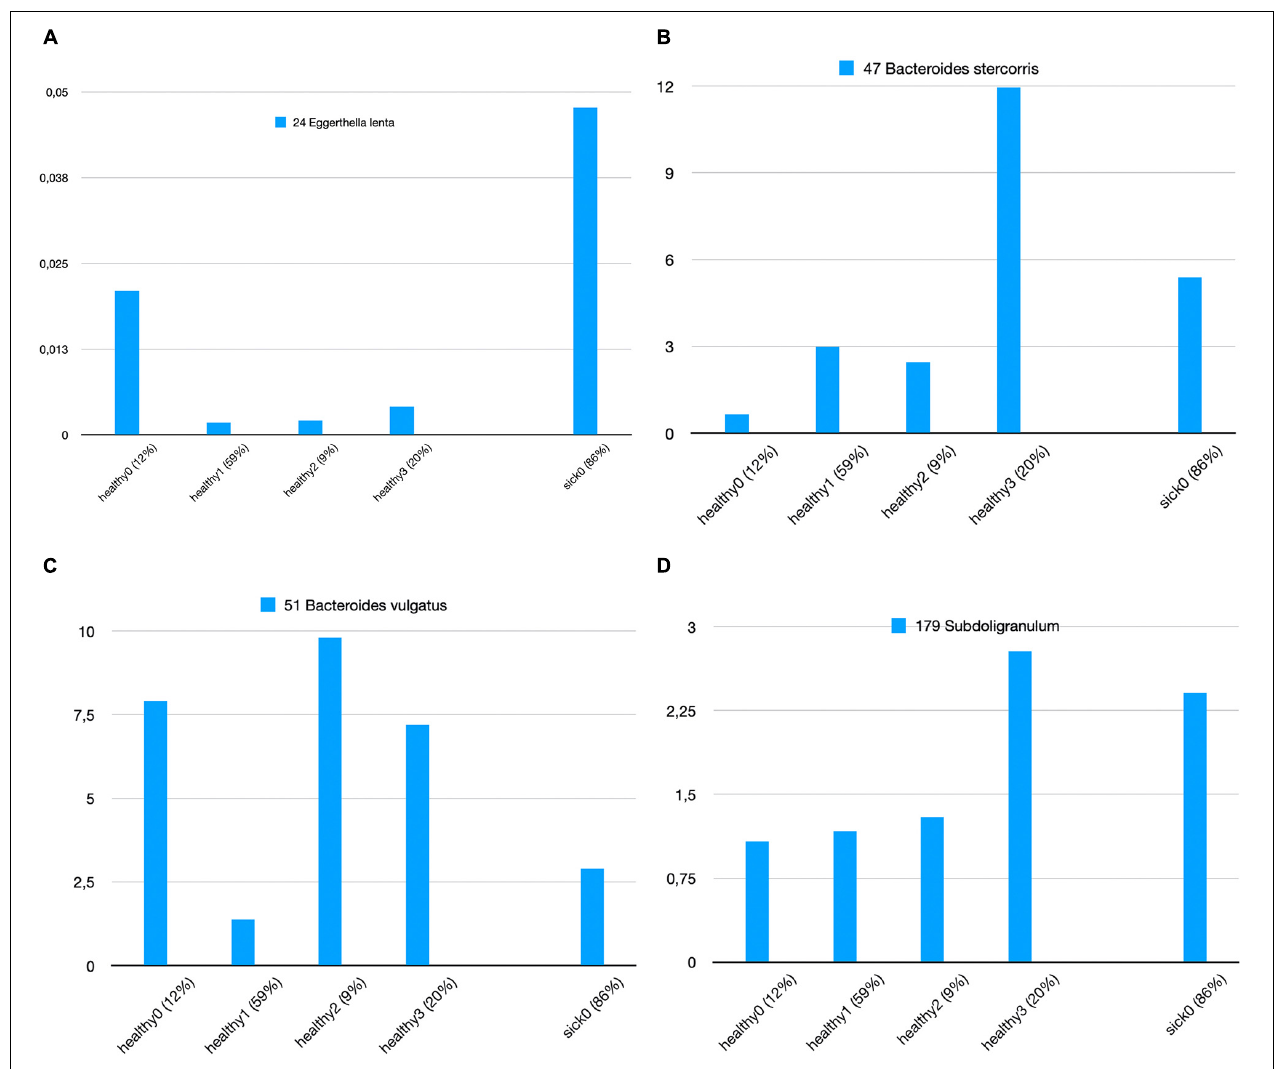
FIGURE 6 | Zoomed-in view of all healthy subgroups and the biggest T2D subgroup for (A) Eggerthella lenta , (B) Bacteroides stercoris , (C) Bacteroides vulgatus , and (D) Subdoligranulum